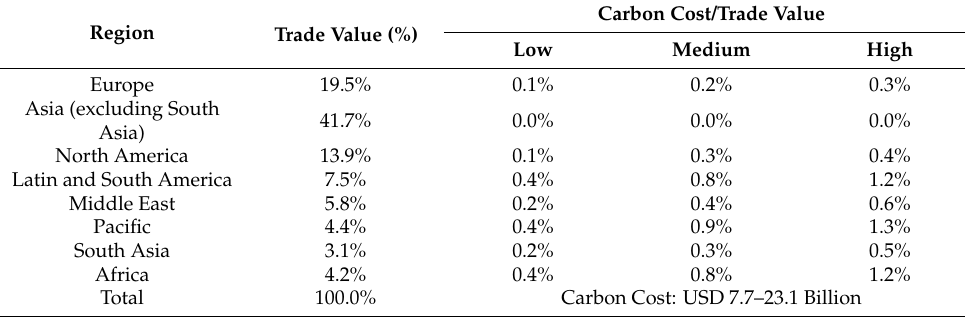
Table 4. Carbon costs as a share of total import and export trade, 2021. Region Trade Value